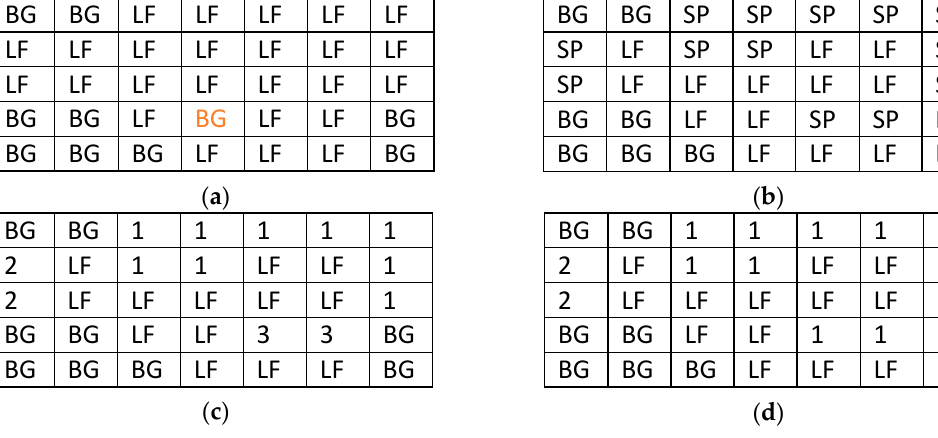
Figure 1. Spot identification method. Separation of the background ( a ), spot identification ( b ), initial spot numbering ( c ) and final spot numbering ( d ). Notations: BG-background pixel, LF-normal leaf, SP-lesion spot.